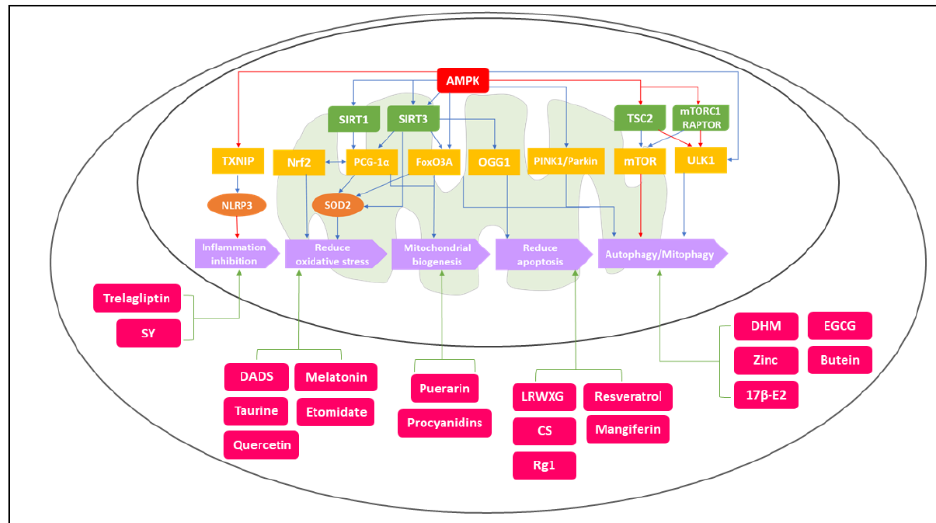
Figure 1. The diagram shows the AMPK–SIRT signaling pathways related to OA pathogenesis and the potential treatment options for OA targeting at mitochondrial pathways. The outer circle is the cell membrane, and the inner circle is the mitochondrial outer membrane. The red, green, yellow, and orange blocks represent the regulatory molecules and the purple blocks represent the final metabolic responses in the AMPK–SIRT signaling pathways. The light-red blocks represent potential treatment drugs. The blue arrow means activation, and the red arrow means inhibition in the signaling pathways. The activation of AMPK–SIRT1/SIRT3–PCG–1 α /FoxO3A, AMPK–SIRT3–OGG1, AMPK–PINK1/Parkin, and AMPK-ULK1/mTOR could reduce oxidative stress, promote mitochondrial biogenesis, reduce apoptosis, enhance autophagy/mitophagy, and inhibit inflammatory responses. In addition, the targeting metabolic pathways of potential treatment options—DADS, Taurine, Quercetin, Melatonin, LRWXG, CS, Rg1, DHM, Puerarin, Zinc, 17 β -E2, Trelagliptin, Etomidate, SY, EGCG, Resveratrol, Procyanidins, Butein, and Mangiferin—are shown above. The green arrows indicate the metabolic effects of these potential treatment